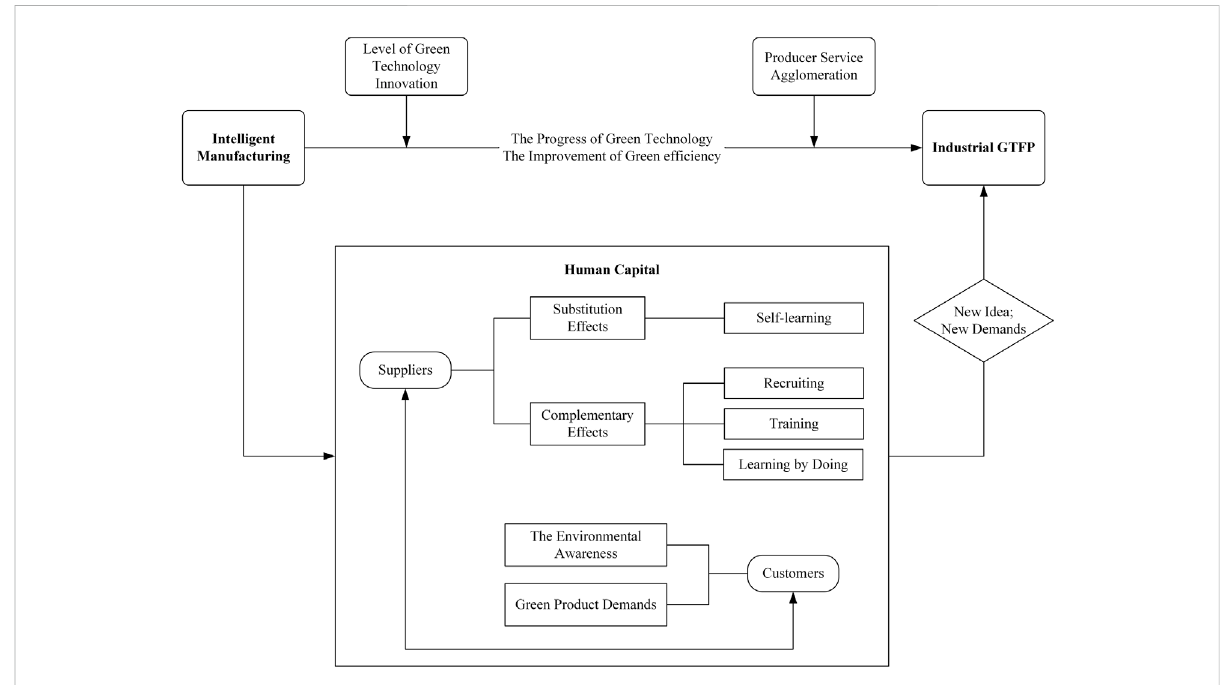
FIGURE 1 Theoretical